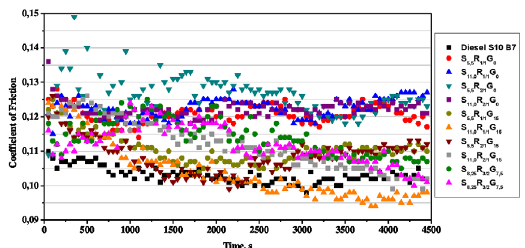
Figura 4. Coefficient of friction of the contact disc-ball